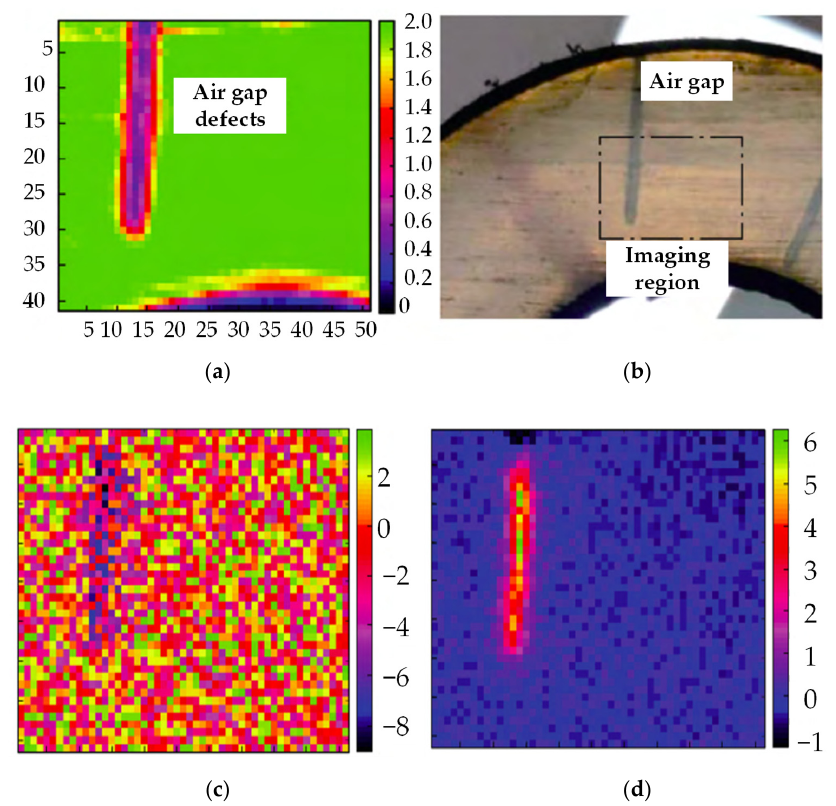
Figure 19. Terahertz amplitude imaging and phase imaging [74]. ( a ) THz amplitude imaging; ( b ) physical samples; ( c ) Time delay t = 253 ps; ( d ) Time delay 254 ps.